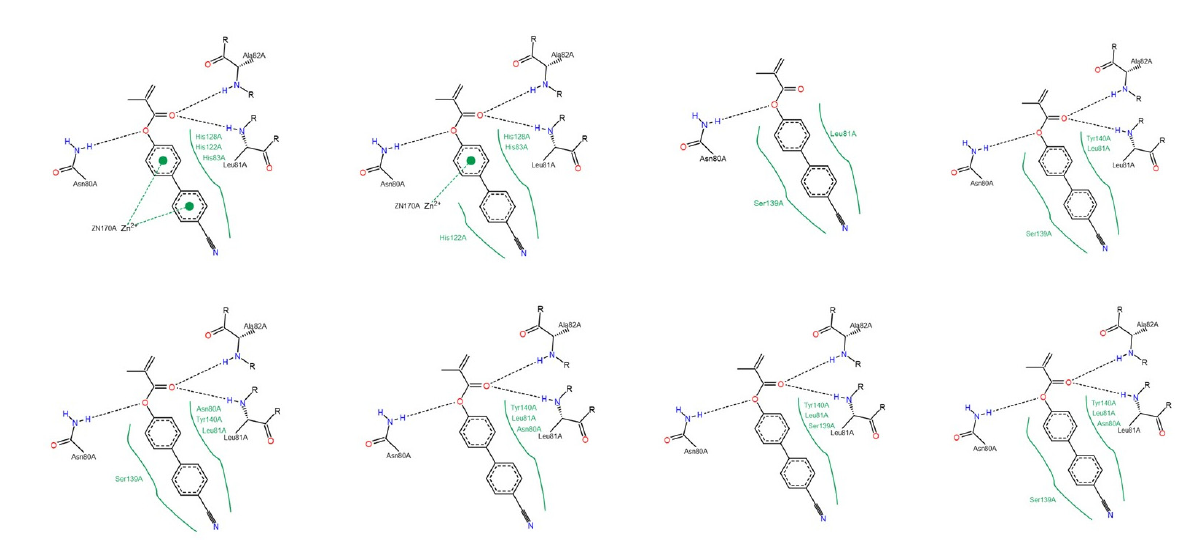
Figure A6. Interactions between compound A and MMP-1, by PoseView calculations.